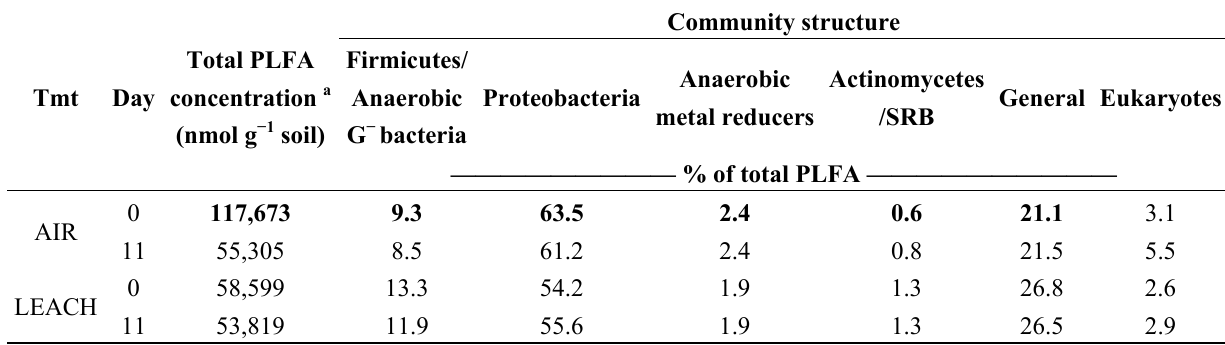
Table 1. Active microbial biomass and relative amounts of PLFA for different microbial groups in AIR and LEACH soils before (Day 0) and after (Day 11) the tetracycline dosing period. Values are means ( n = 3).